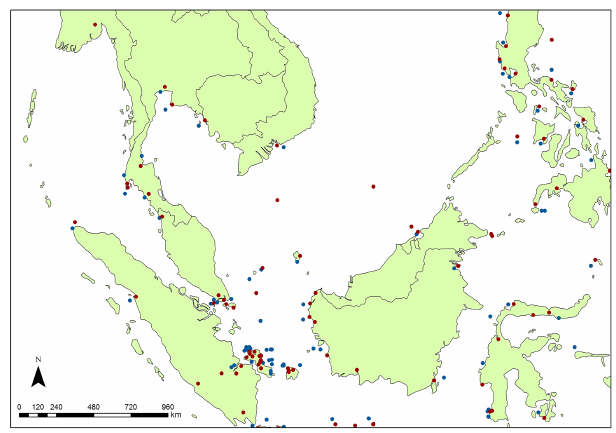
Figure 4. Map of the original station location situated in the ocean (blue dots) and the updated station location (red dots) for Java and parts of Indonesia.